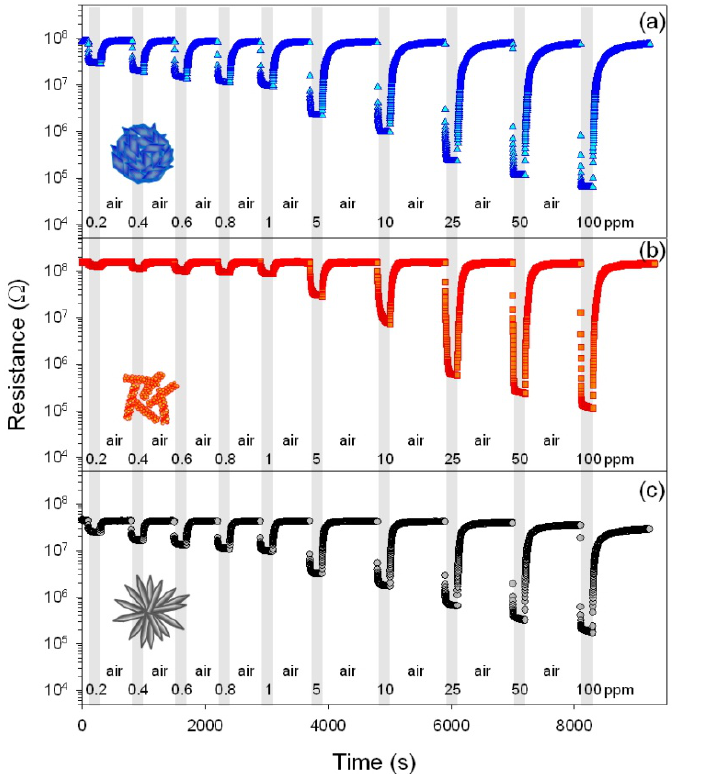
Figure 7. C H OH sensing transients of ( a ) H-NS sensor; ( b ) NR sensor; and ( c ) H-NR 2 5 H OH concentration: 0.2–100 sensor at 400 ° C. (C 2 5